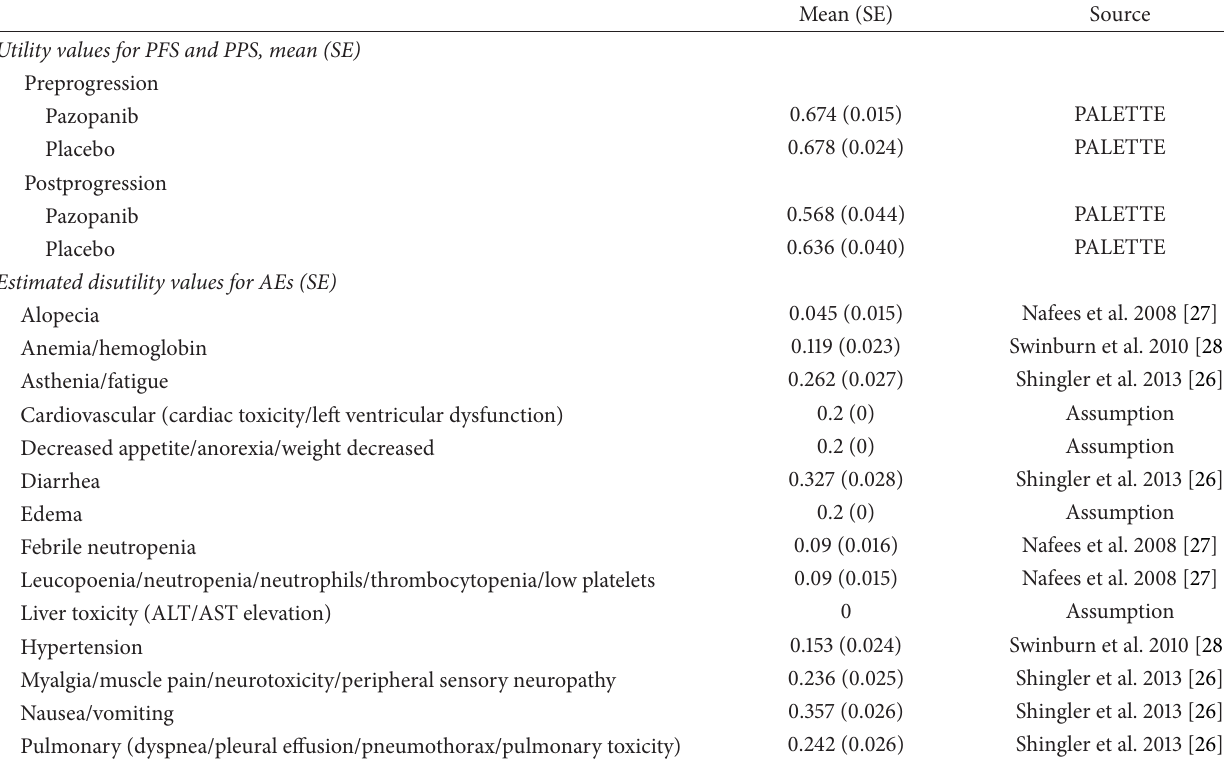
Table 3: Utility values used in the model.